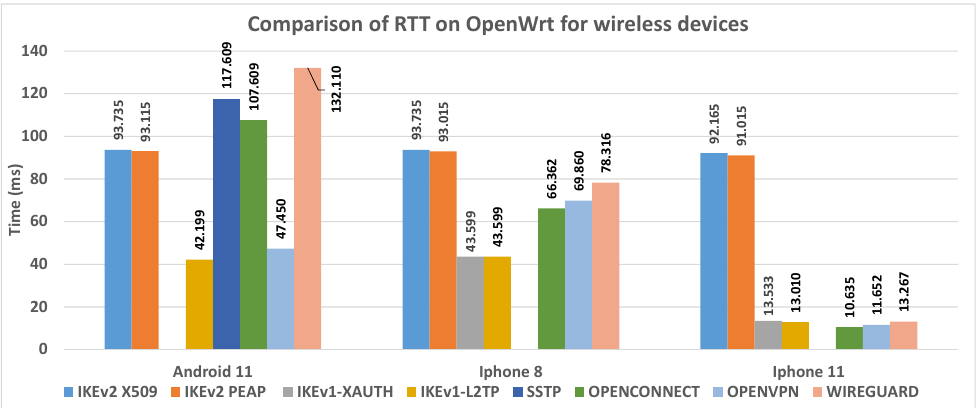
Figure 25. RTT data collected during the VPN connection tests with wireless devices. From the comparative analysis of Figures 21 and 22, AES-256-GCM, using TLS-ciphers 1,3, turns out to be the best data cipher in terms of throughput and RTT, followed by AES- 128-GCM and CHACHA20-POLY1035. From the analysis of Figure 23, OpenWRT results have an average Phy Rate ranging between 29 and 33 Mbps on the TP-LINK TL-WR841N device. From the comparative analysis of Figures 24–27, OpenWRT is the best device/OS for wired connections, while iPhone 11 is the best RoadWarrior wireless client.